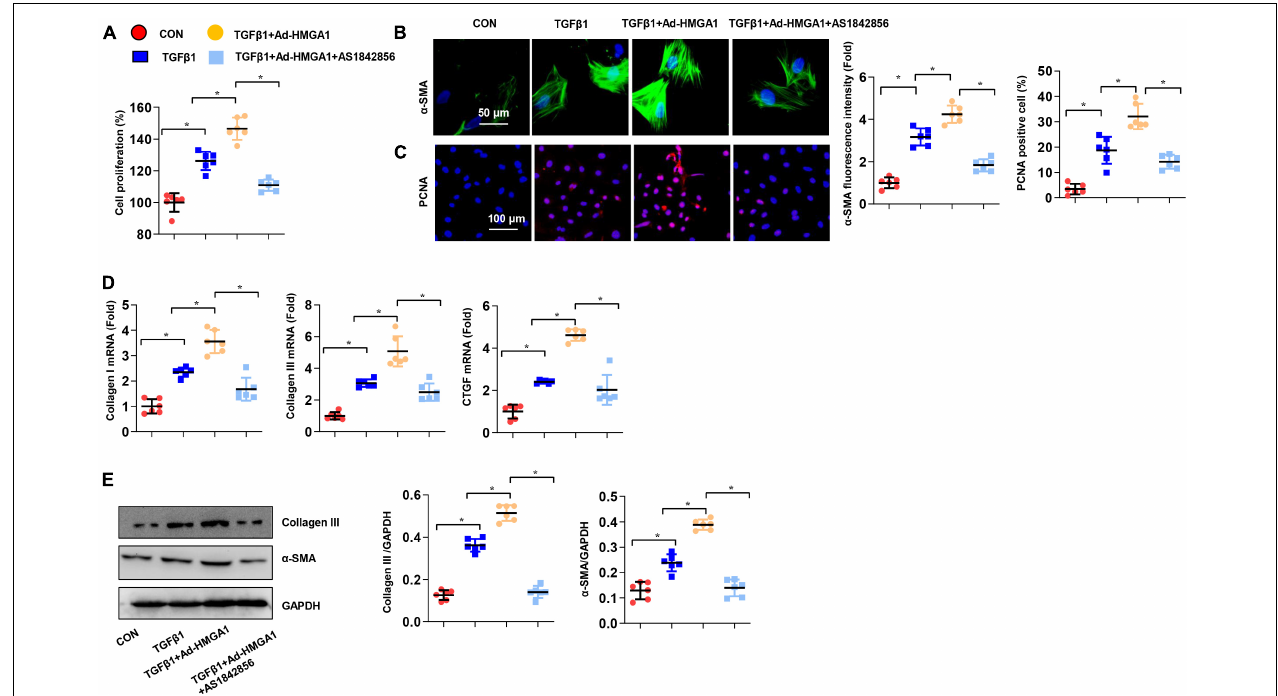
FIGURE 6 | FOXO1 inhibition abolished the effect of HMGA1 overexpression in vitro . CFs were treated with AS1842856 (10 µ M) and then treated with TGF β 1 for 24 h. (A) Cell proliferation detected by CCK8 assay ( n = 6). (B) Immunofluorescence staining of α -SMA ( n = 5). (C) Immunofluorescence staining of PCNA ( n = 5). (D) Transcription levels of collagen I, collagen III, and CTGF ( n = 6). (E) Protein levels of collagen III and α -SMA ( n = 6). * p <